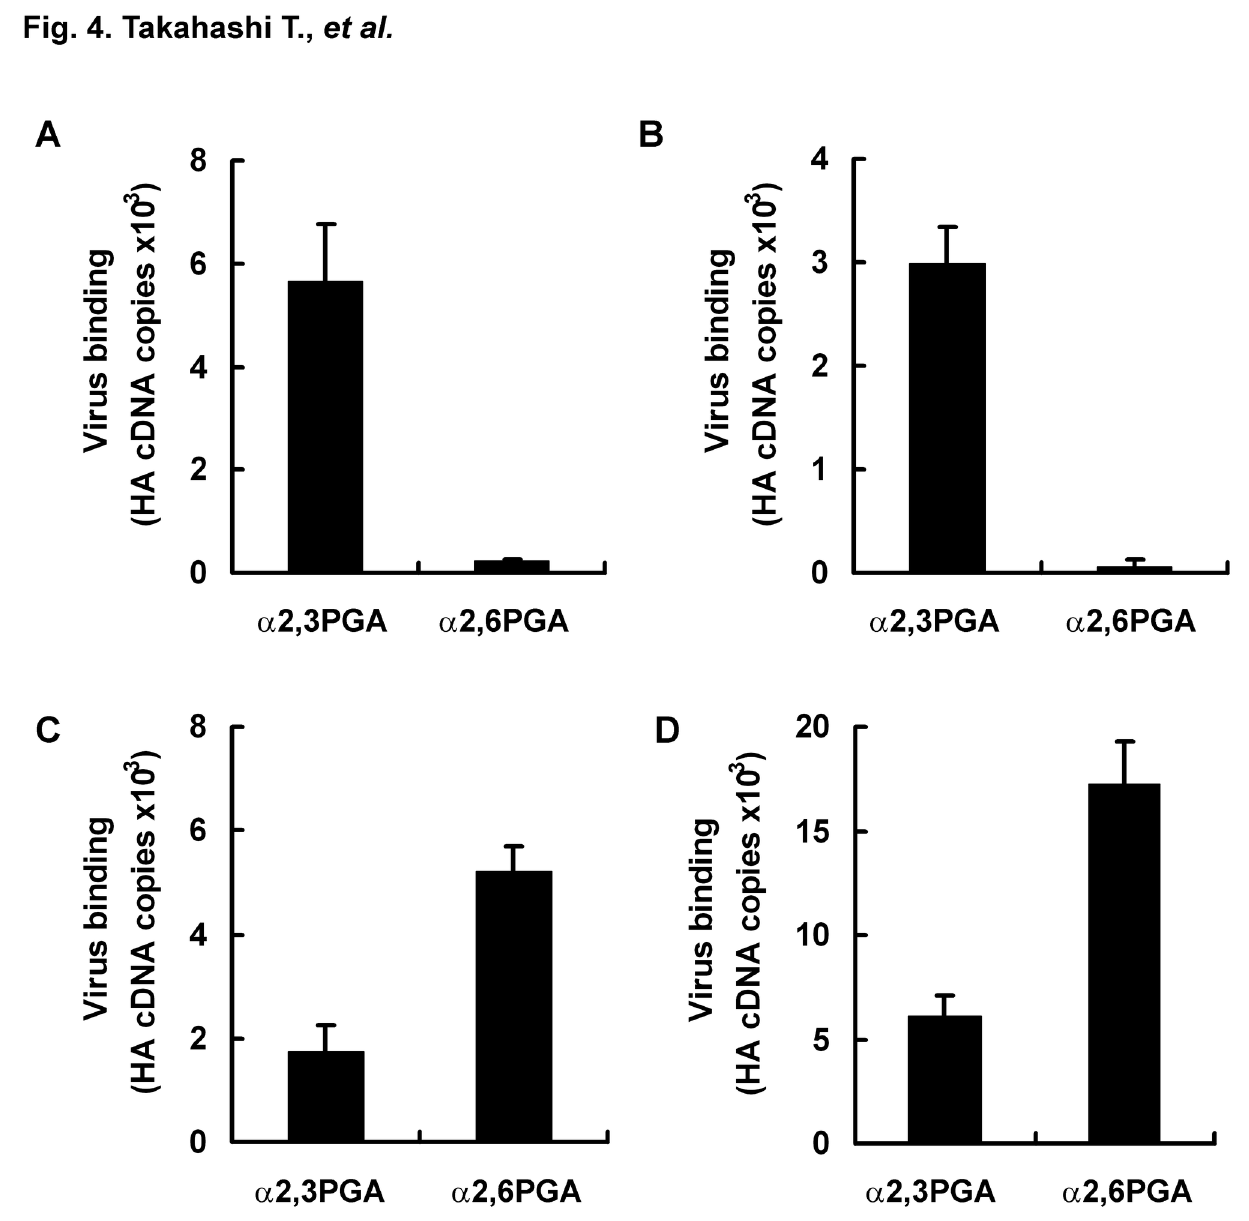
Figure 4. Influence of swabs from chickens on the real-time PCR assay for receptor binding specificity. A microplate was immobilized with 200 ng/well of α2,3PGA or α2,6PGA and then blocked with 1% lipid-free BSA in PBS at 4 °C overnight. Avian IAV D313 (A and B) or human IAV M71 (C and D) (2° HAU, 25 μl/well) was mixed with a 5-dilution suspension of a trachea swab (A and C) or cloaca swab (B and D) (25 μl/well) from healthy chickens. The mixtures (50 μl/well) were incubated for 2 h at 4 °C